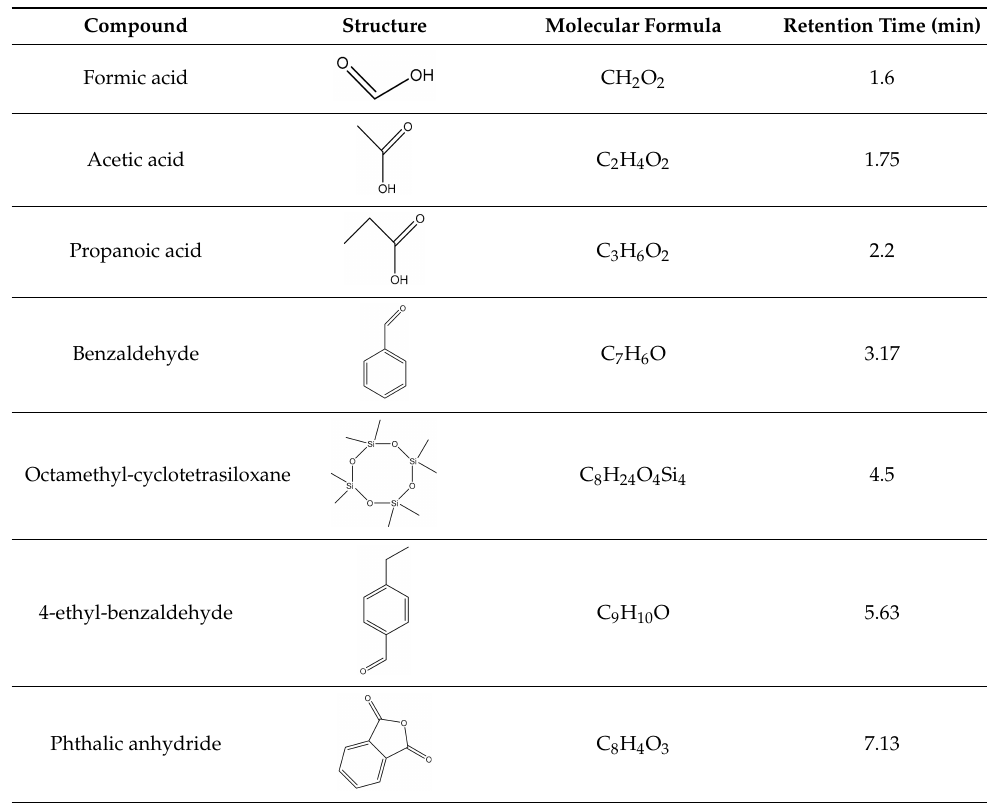
Figure 7. Total ion chromatogram of decomposed compositions by GC–MS analysis. Table 3. Analysis of degradation products by